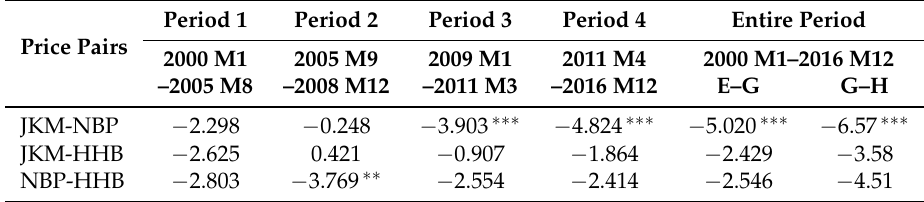
Table 3. Engle–Granger cointegration